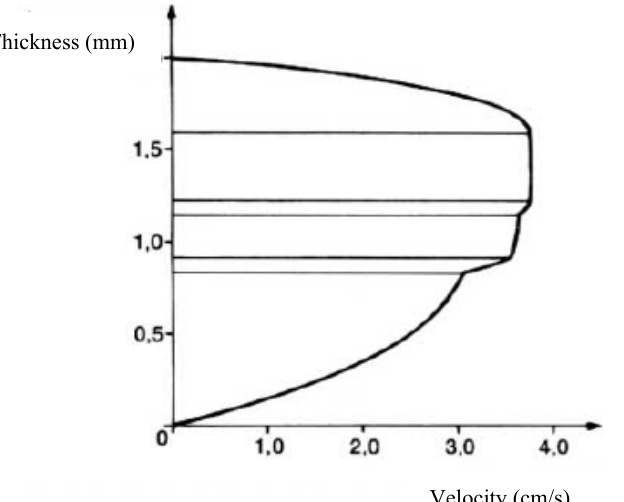
Figure 15. Velocity profile in a multilayer flow (Reprinted from Ref. [15]).